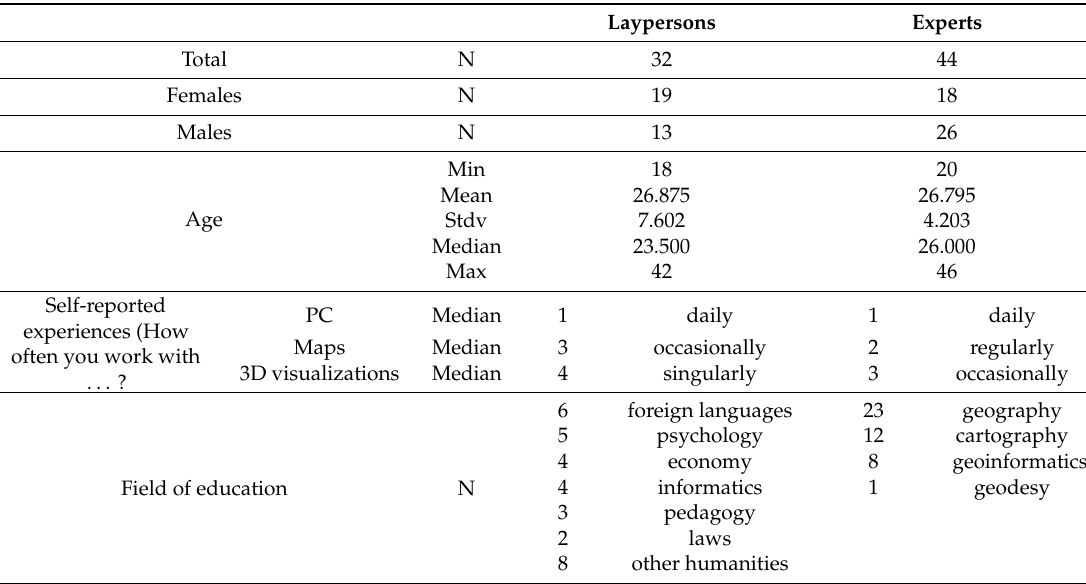
Table 2. Participant’s